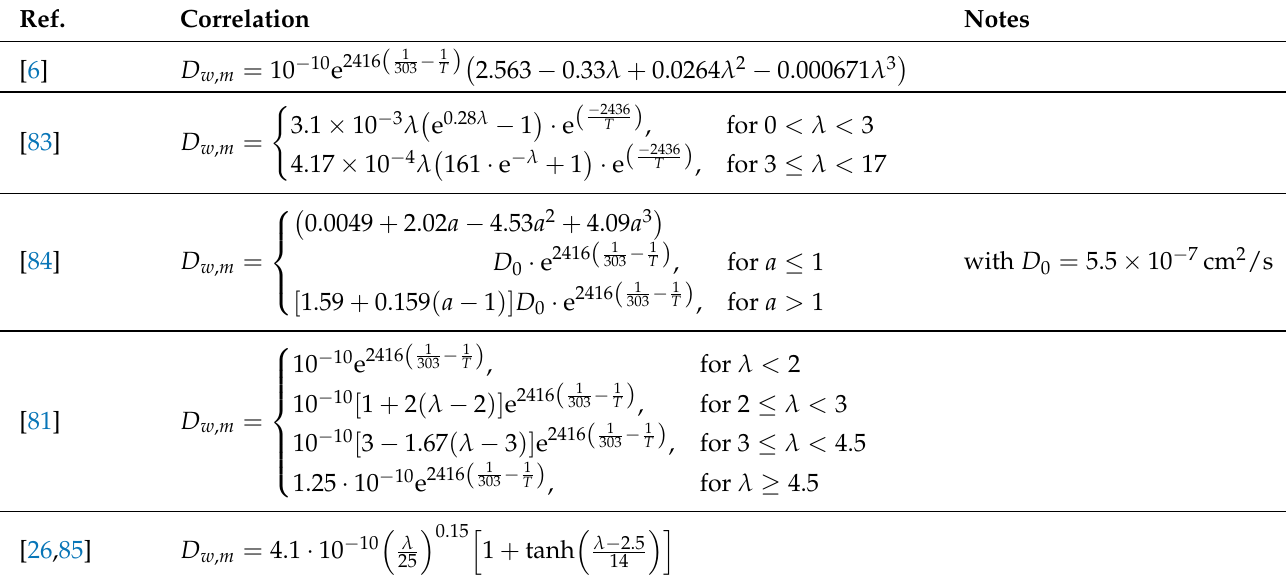
Table 12. Correlations for dissolved water diffusion coefficient D w in [m 2 /s].